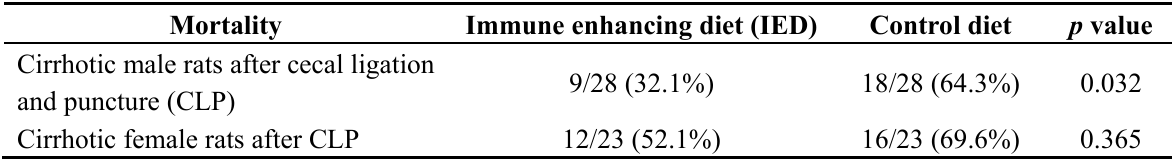
Table 2. Comparison of mortality between different diets in cirrhotic male and cirrhotic female rats.